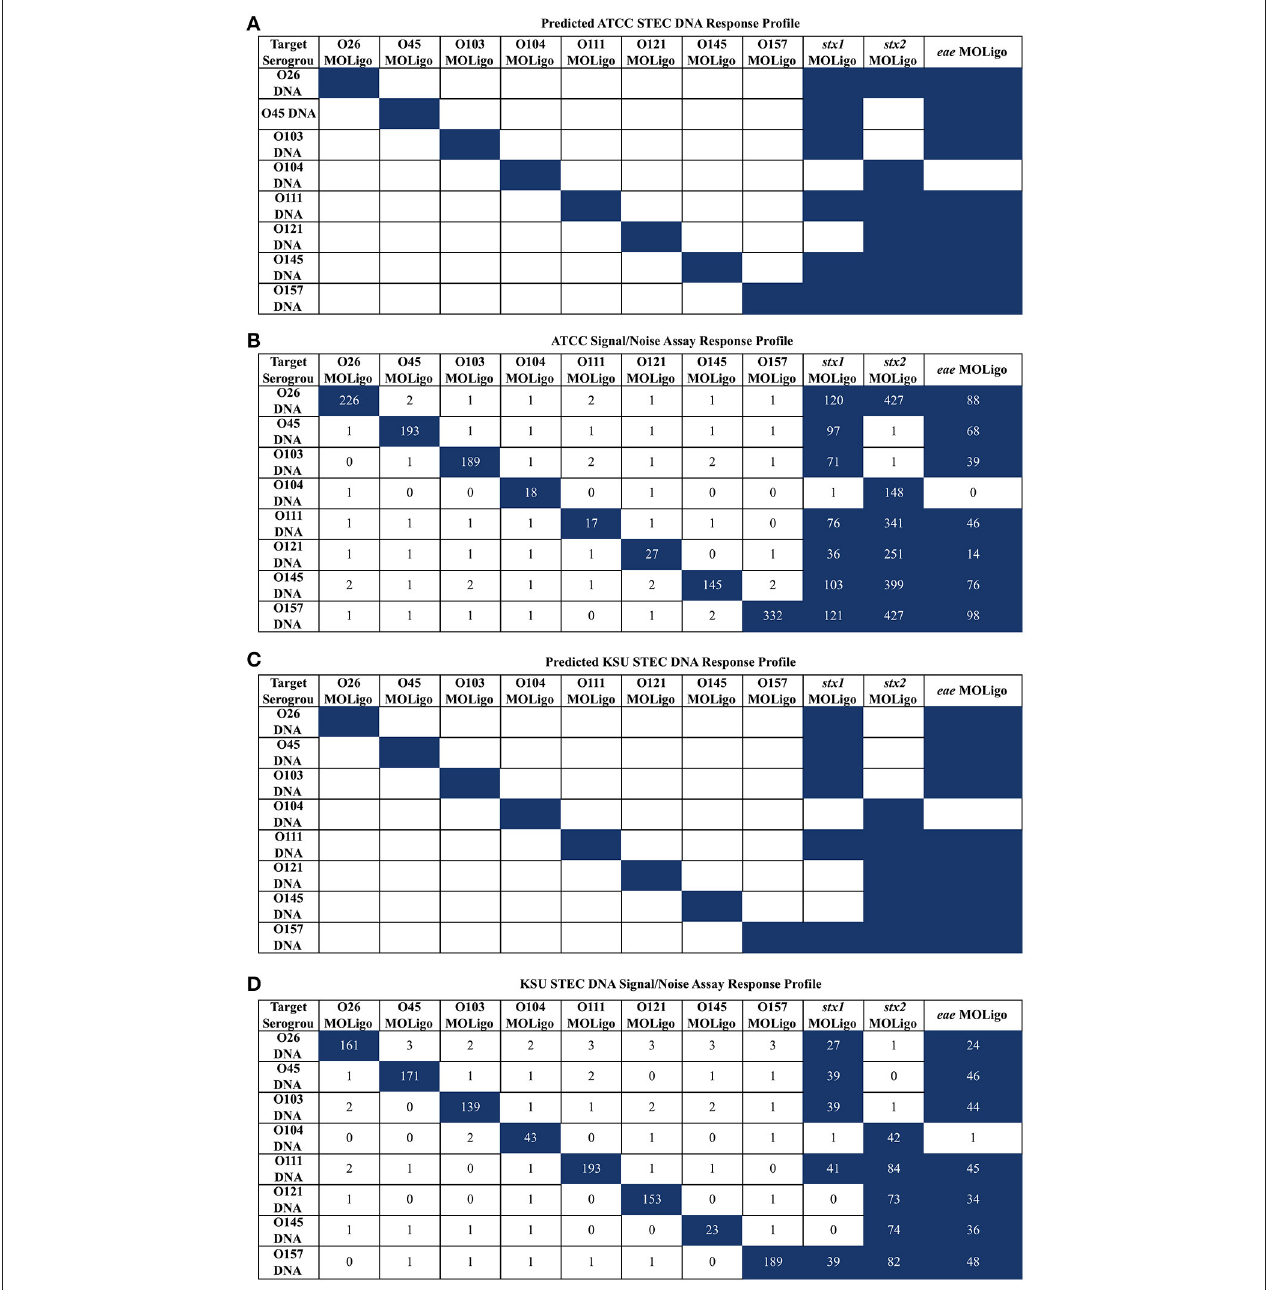
FIGURE 1 | STEC-8 MOL-PCR assay evaluated against commercial STEC associated DNA (ATCC) and STEC associated DNA from laboratory cultures (KSU), reported as signal to noise ratio of median fluorescence intensity. Values were rounded to the nearest integer where zero values were from reported zero median fluorescence intensity; predicted highest and assay highest values highlighted in blue. (A) ATCC STEC DNA predicted interactions agreed with the (B) corresponding assay results, with the exception of O121 (BAA-2219D) stx 1 reporting as present when known not to be. (C) KSU STEC DNA predicted interactions were in complete agreement with the assay results (D) for the KSU